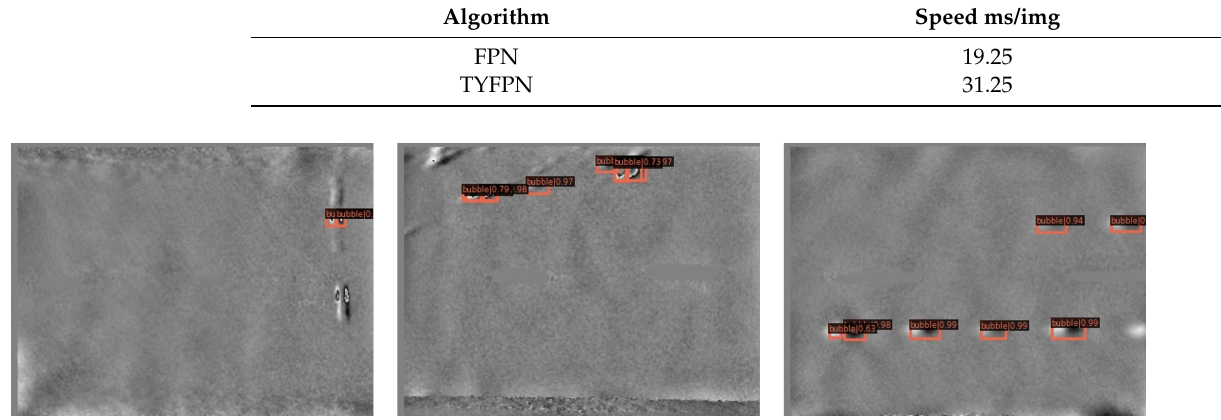
Figure 10. Detection results of